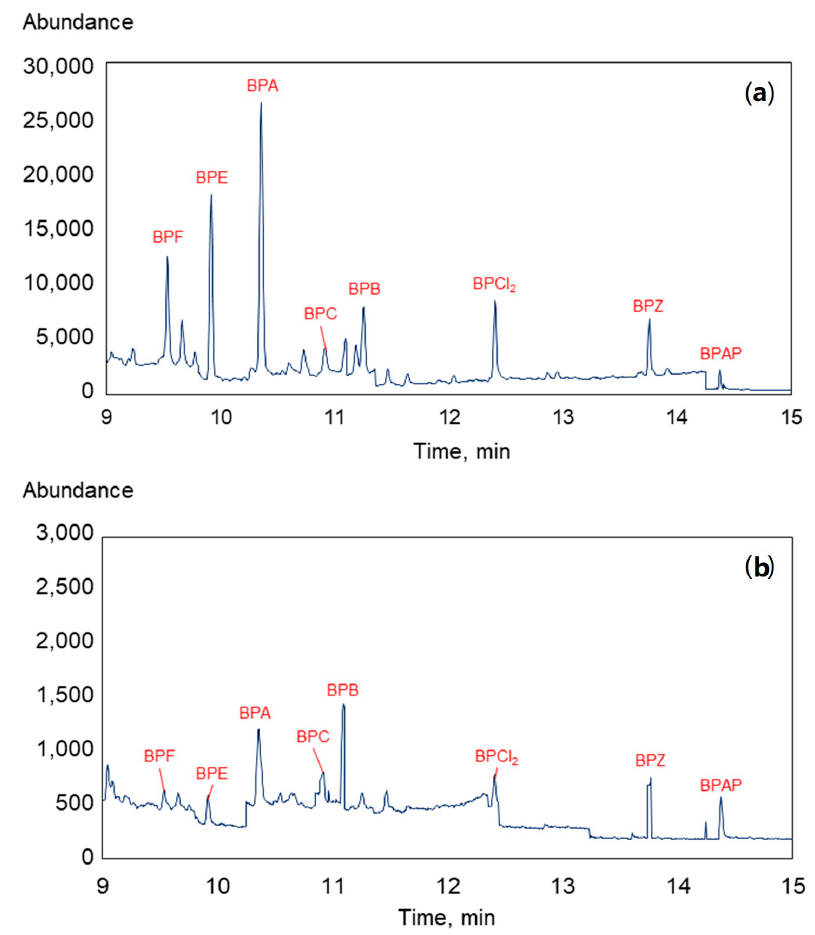
Figure 4. Chromatograms of raw ( a ) and treated ( b ) wastewater